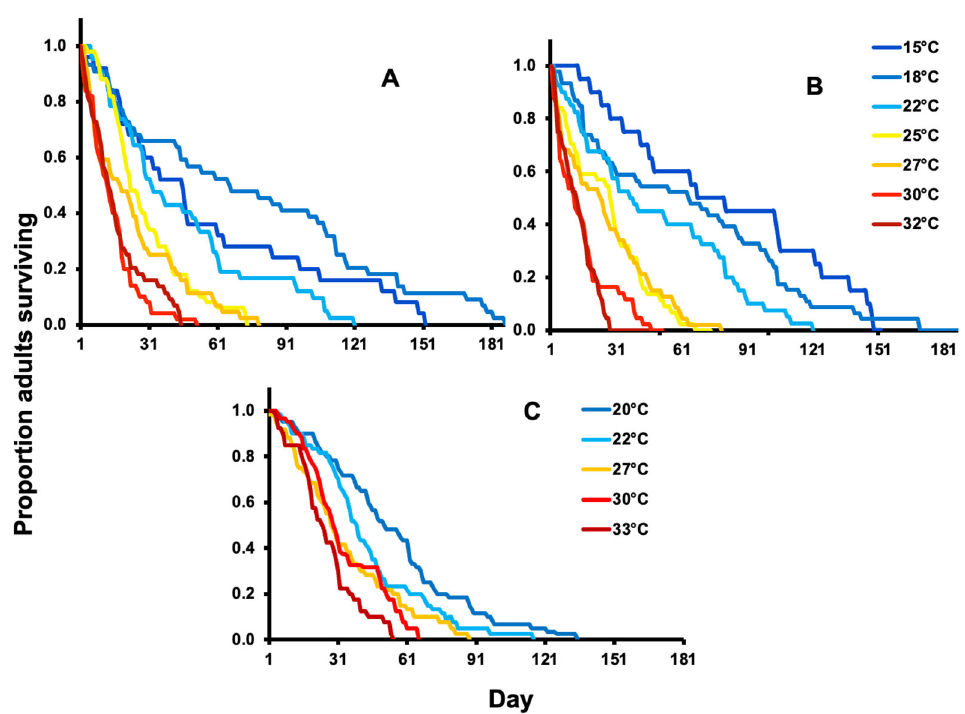
Figure 1. Proportion of H. halys adult survival at constant temperatures (°C) of Oregon female ( A ) and male ( B ) and New Jersey female ( C ).